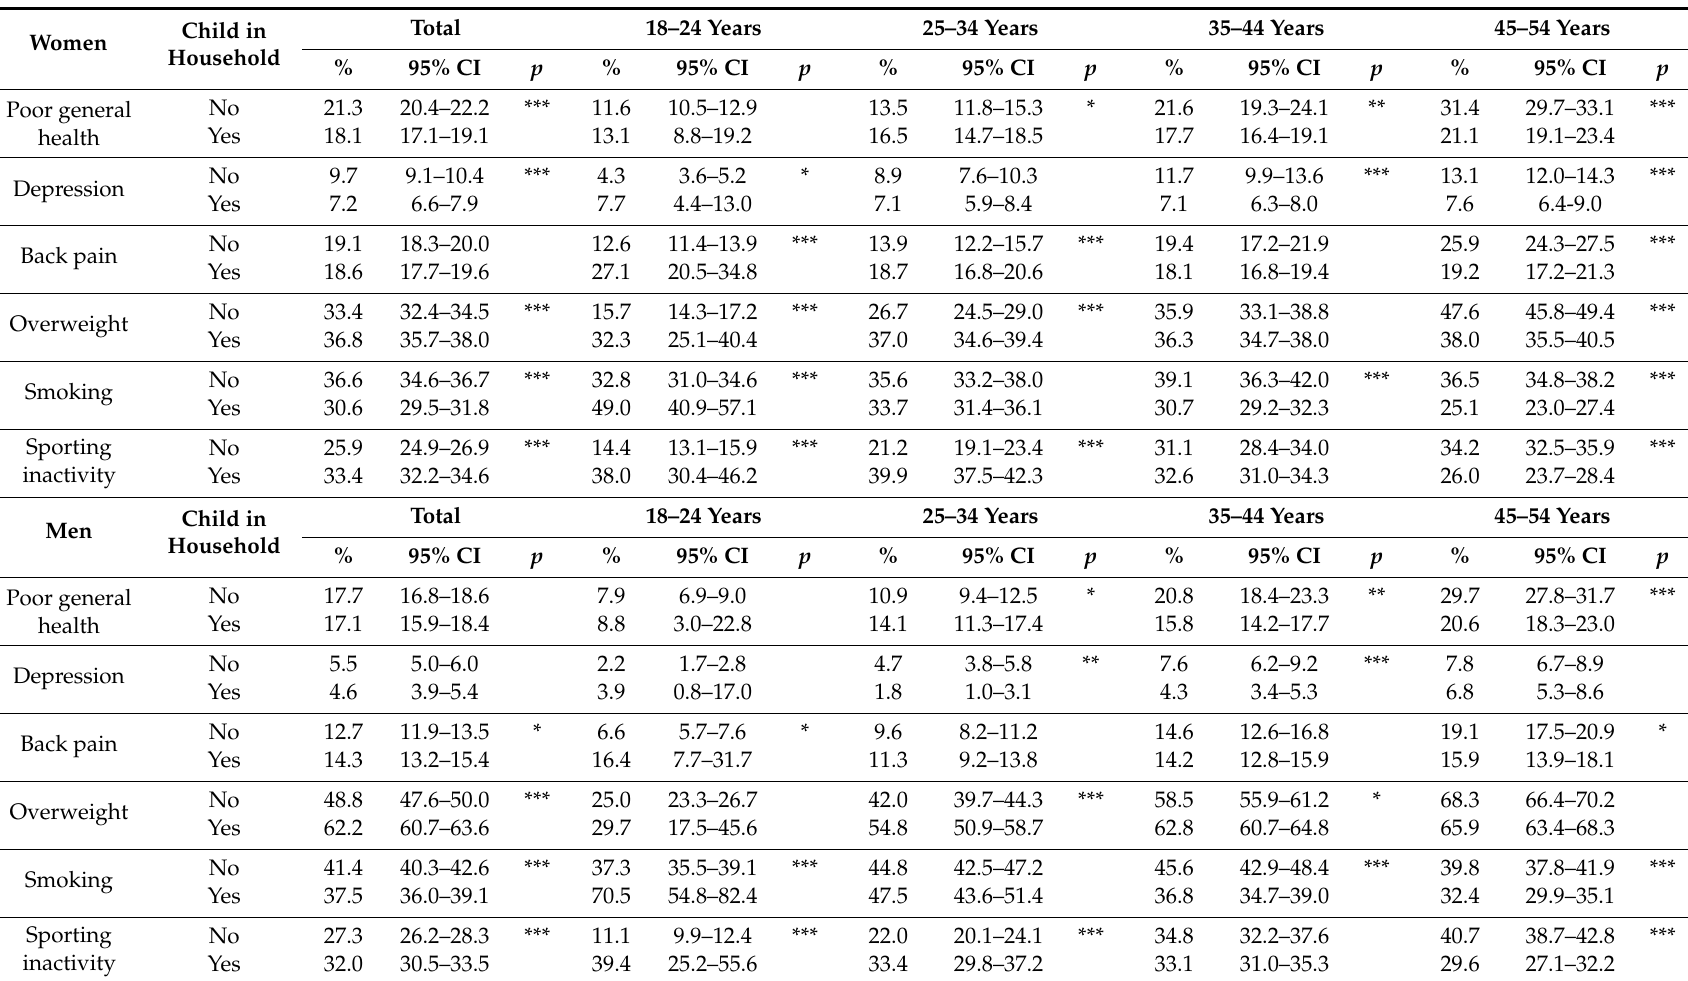
Table 2. Health of women and men by parental status, stratified by age groups and sex (prevalence in %, 95% CI, p